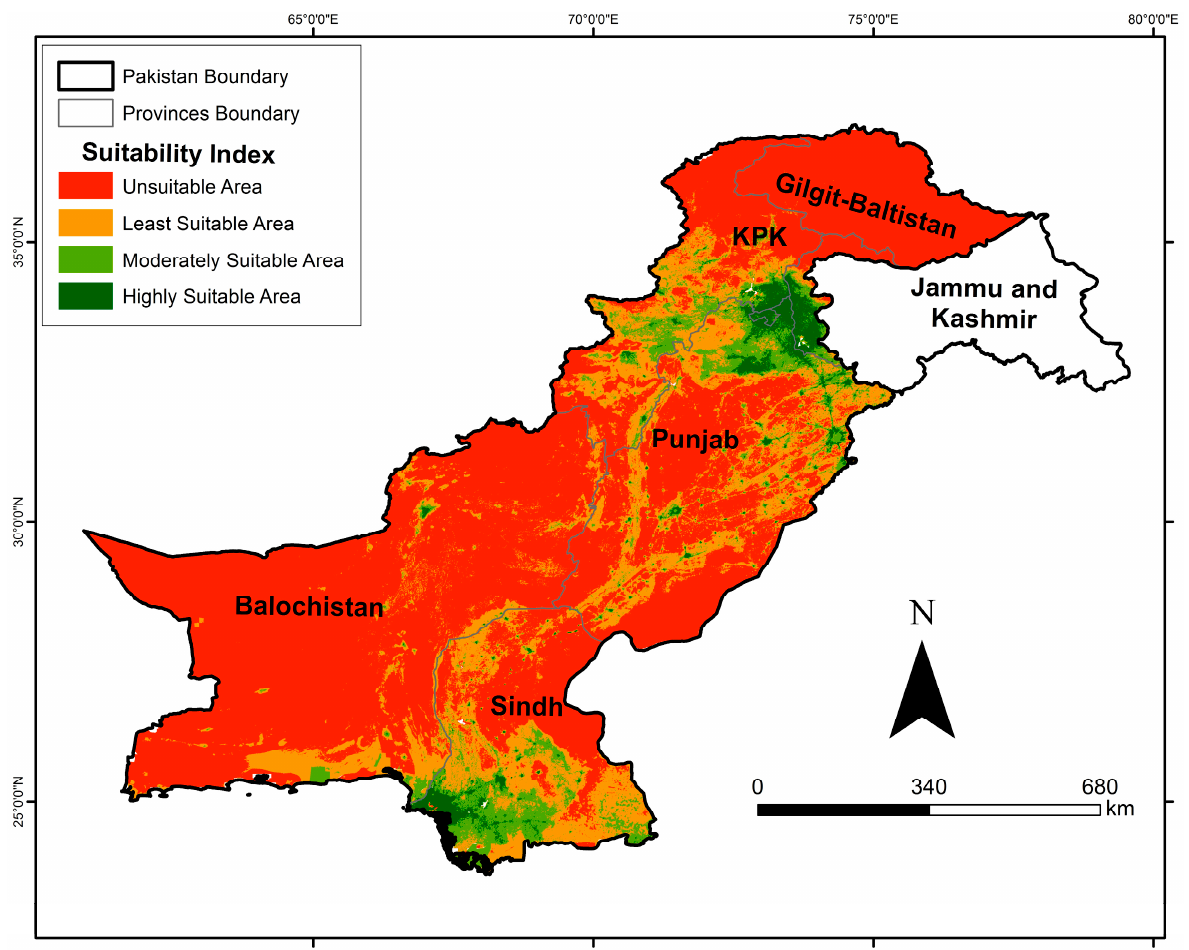
Figure 4. Distribution of different types of suitable habitats for steppe eagles in Pakistan based on MaxEnt modelling using presence-only data.